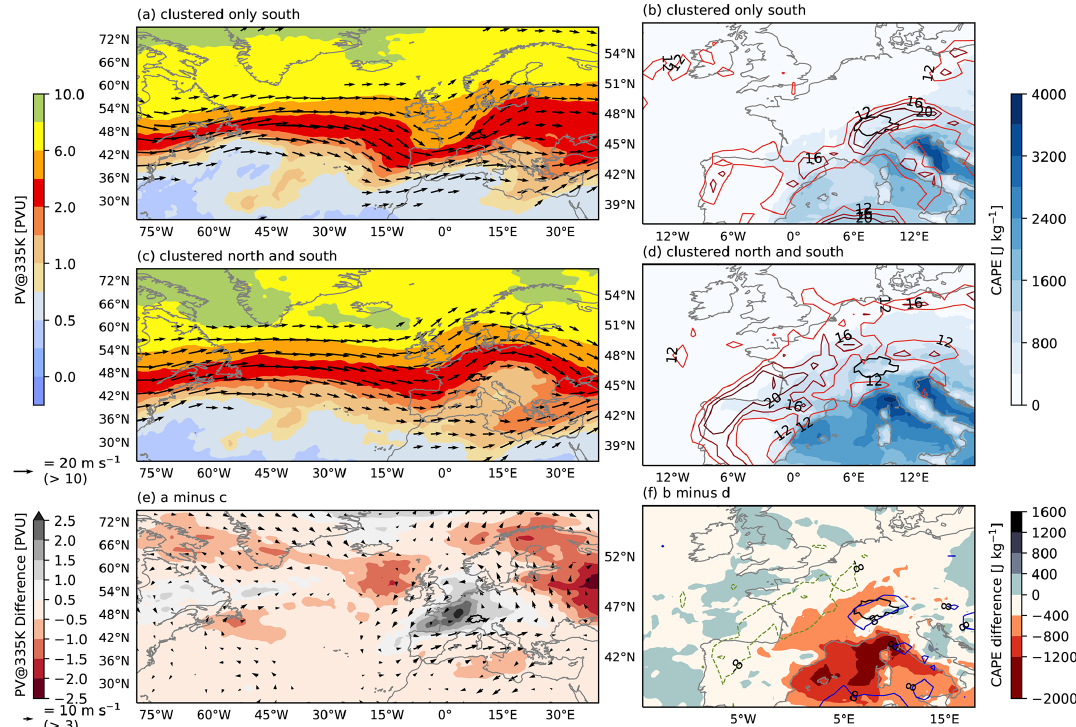
Figure 13. PV at 335K, horizontal winds at 250hPa (a, c, e) , and MUCAPE and front frequency (b, d, f) during clustered hail days occurring only south of the Alps (a, b) , during clustered hail days occurring both north and south of the Alps (c, d) , and their differences ( e, f ; significances not shown). See Figs. 5 and 6 for